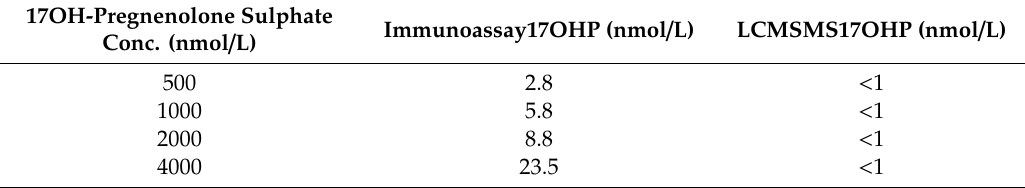
Table 2. Comparison of interferences from 17-hydroxpregnenolone